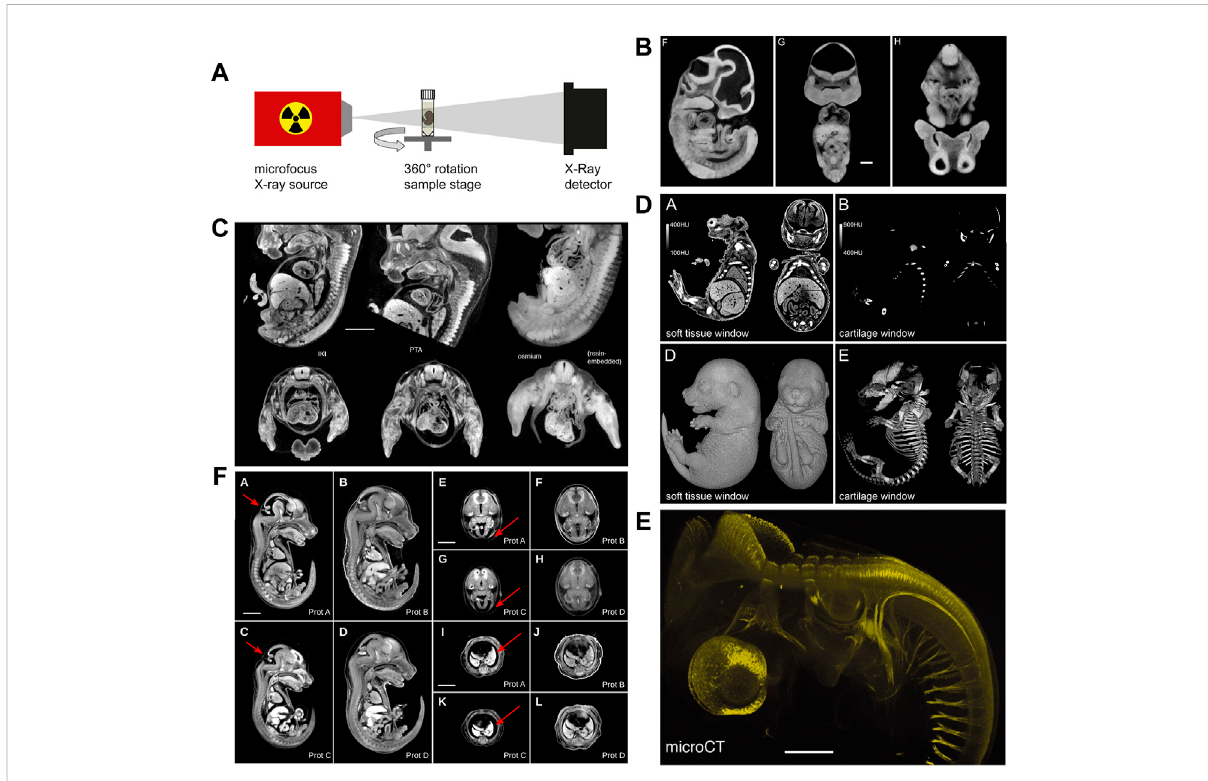
FIGURE 3 MicroCT image acquisition and examples of non-speci fi c and tissue-speci fi c staining. (A) Schematic representation of a micro-CT system comprised of an X-ray source and an X-ray detector coupled to a camera. Samples are mounted to a rotating stage between the source and the detector (Figure 1F from Gabner et al., 2020, Development 147 (11)). (B) MicroCT image contrast derives from differences in X-ray attenuation betweendifferenttissues,achievedbystainingwithX-raydensecontrastagents.Osmiumtetroxidedeliversnon-speci fi ccontrasttoembryonic soft tissue enabling the visualization of structural features (Figures 1F – H from Johnson et al., 2006, PLoS Genetics 2 (4). (C) Mouse embryos stained with iodine (I 2 KI), phosphotungstic acid (PTA), and osmium tetroxide. The different non-speci fi c contrast agents show subtle differences in absorbance levels between tissues (Figure 9 from Metscher 2009a). (D) Selective cartilage staining with ruthenium red enables the simultaneous visualization of cartilage and bone in the developing mouse skeleton (Figures 3A,B,D,E from Gabner et al., 2020, Development 147 (11)). (E) Selective antibody labelling of acetylated α -tubulin in a stage 23 chicken embryo. Antibody binding sites visualized by microCT after horseradish peroxidase- mediateddepositionofX-raydenseatomicsilver[partsofFigure1fromMetscherandMüller,2011,DevelopmentalDynamics240(10)]. (F) Hydrogel- embeddingofmouseembryospriortoiodinestainingsigni fi cantlyreducesshrinkageartefacts.Prot.Aembryostainedwith0.025NI 2 KIwithoutpre- treatment,Prot.Bembryopre-treatedwithhydrogelandstainedwith0.025NI 2 KI,Prot.Cembryostainedwith0.1NI 2 KIwithoutpre-treatment,Prot. Dembryo pre-treated with hydrogel andstainedwith 0.1NI 2 KI(Figure3fromWong etal.,2013b,PLoSONE 8(12). (AandD) reprintedbypermission from the Company of Biologists. (E) reprinted by permission from John Wiley and Sons. (B,C and F) reprinted under the terms of the Creative Commons Attribution